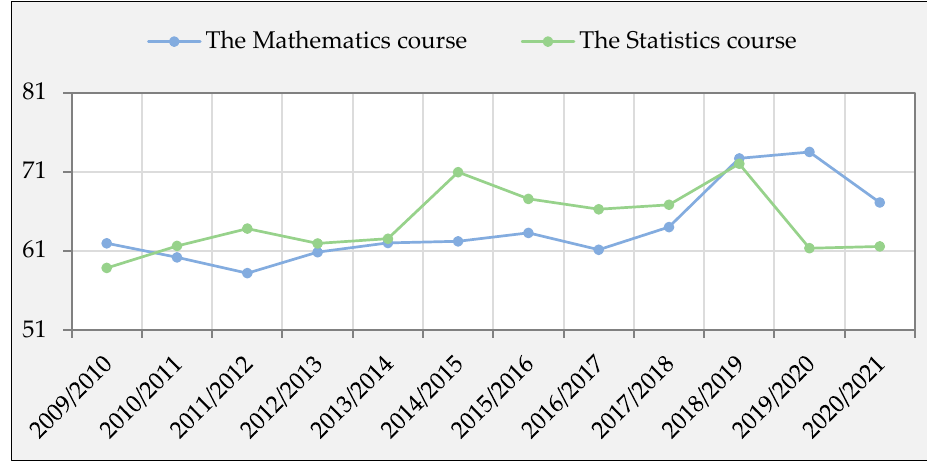
Figure 10. The evolution of overall assessment of the Statistics course and the Mathematics course.